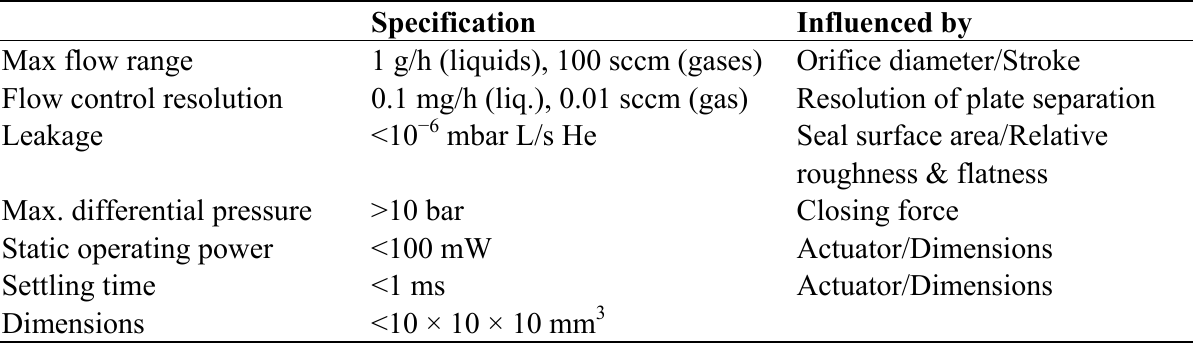
Table 1. Operational specifications of the desired microvalve.